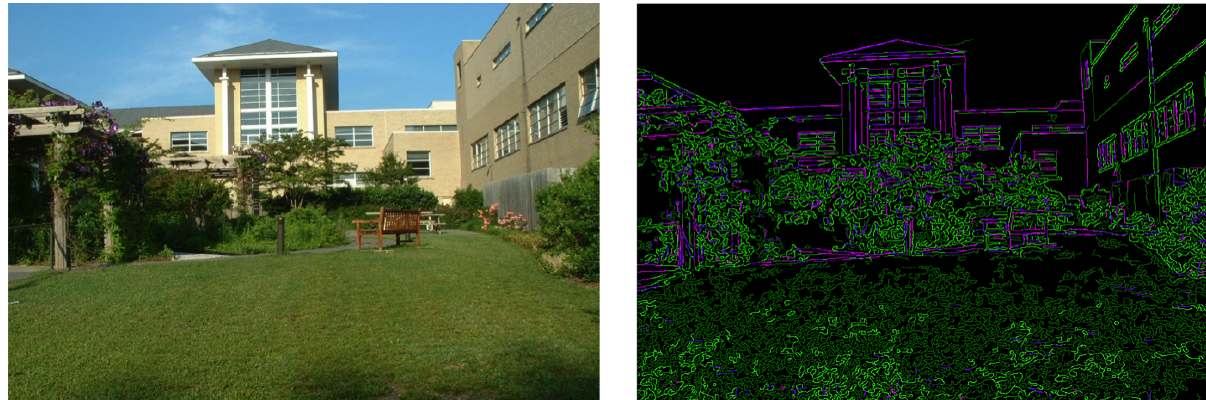
Fig. 5 Use of AI to extract straight edges (magenta) and curved edges (green) from scenes for characterization of different features of the scene (e.g., more ordered vs. more disordered [45–48] as well as providing privacy protection). Figures adapted from Ref.